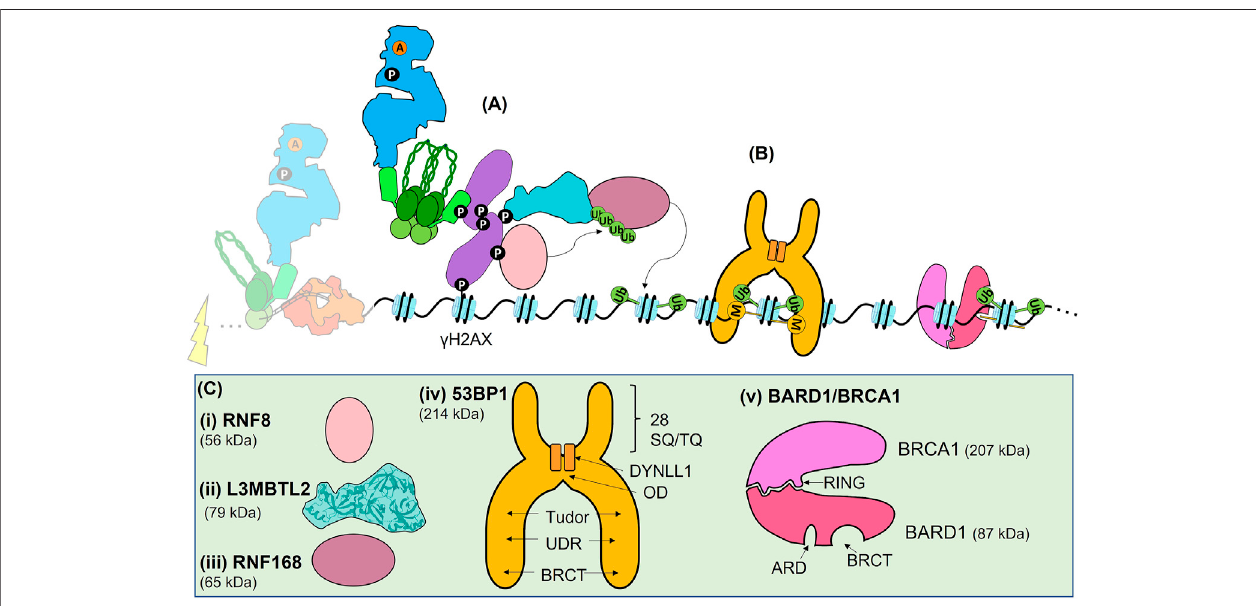
FIGURE5| The EarlyATM-dependent DSB response results inthe ubiquitination ofhistoneH2A(X) (H2A(X)13/15ub) needed forLate protein recruitment. (A) DSB signaltransduction.TheATM-dependentphosphorylationofMDC1providesadockingsitefortheE3ubiquitinligaseRNF8,andtheATM-dependentphosphorylationof S335 of L3MBTL2 allows it to bind to the FHA domain of MDC1, bringing it in close contact with RNF8. RNF8 polyubiquitinates L3BMTL2 on K659 via K48-linkage, providing a platform for RN168 to bind. RNF168 then monoubiquinates H2A(X)K13/15. (B) Together, H2A(X)K15ub and the replication-dependent methylation state of H4K20 recruits either 53BP1 or BARD1, which is in complex with BRCA1. (C) Schematics or structures of RNF8, L3BMTL2, RNF168, 53BP1, and BARD1/ BRCA1 are shown where known, or informed by known domains where the full structure is not solved. (i) RNF8 is an E3 ubiquitin ligase, that interacts with the E2 ubiquitinligaseUBC8orUBC13(notshown). (ii) L3MBTL2structure. (iii) RNF168E3ubiquitinligaseinteractswiththeUBE2NorUBC13E2ubiquitinligase(notshown). (iv) 53BP1 schematic. The UDR domain binds to H4K20me2 and its tandem Tudor domain binds to H2A(X)K15ub. Dimerization of 53BP1 is promoted by the OD and DYNLL1.28SQ/TQsitesintheNterminalcanbephosphorylated fordownstreamproteinrecruitment. (v) TheARDdomainofBARD1bindstheH4K20me0mark,while its BRCT domain binds H2A(X)K15ub. BARD1 is in complex with BRCA1. Note that for clarity the DSB and Early ATM signalling proteins are faded